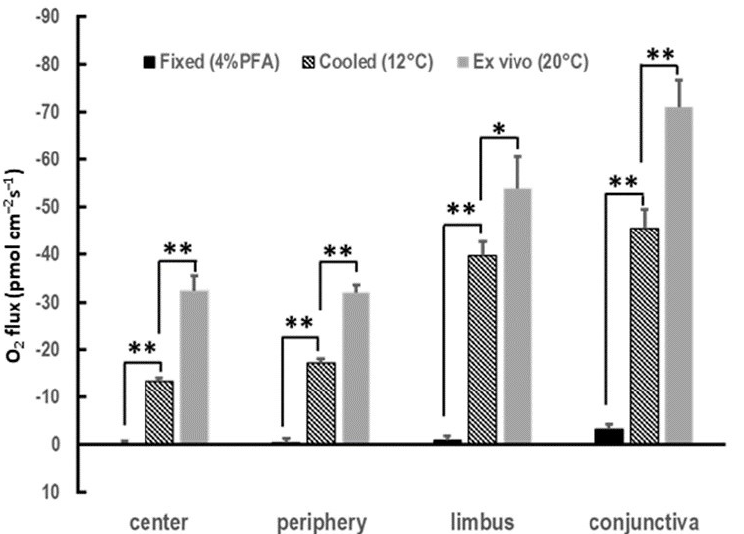
Figure 4. O 2 Flux values resulted from active metabolism of the tissue. Ex vivo mouse eyes